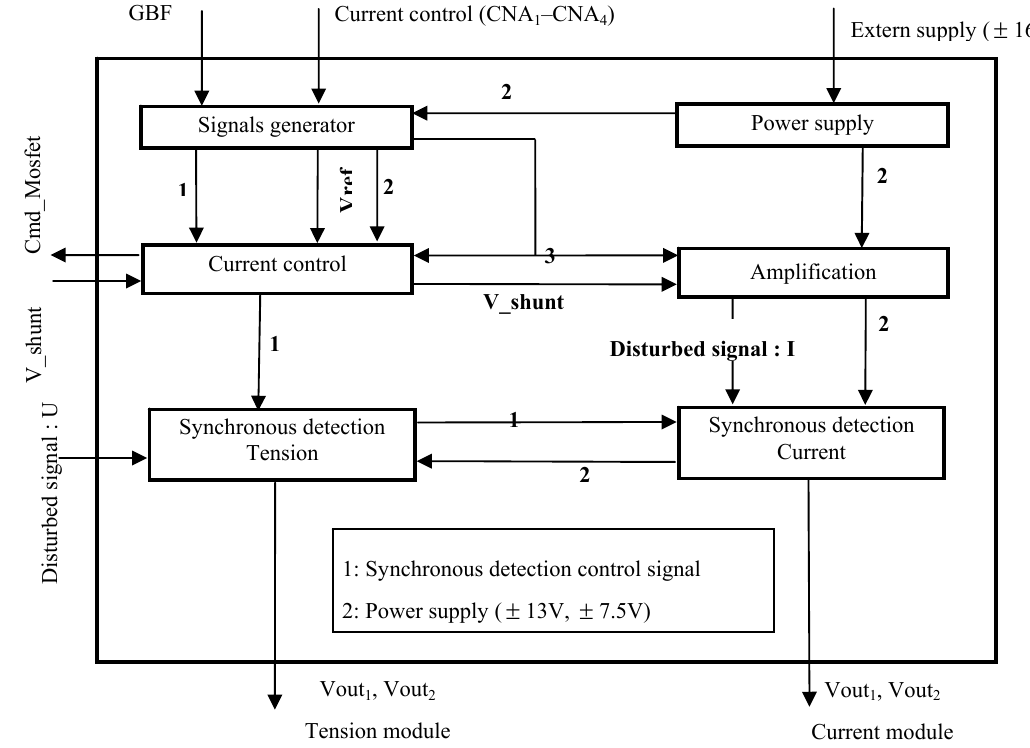
Figure 5. Systemic representation of the test